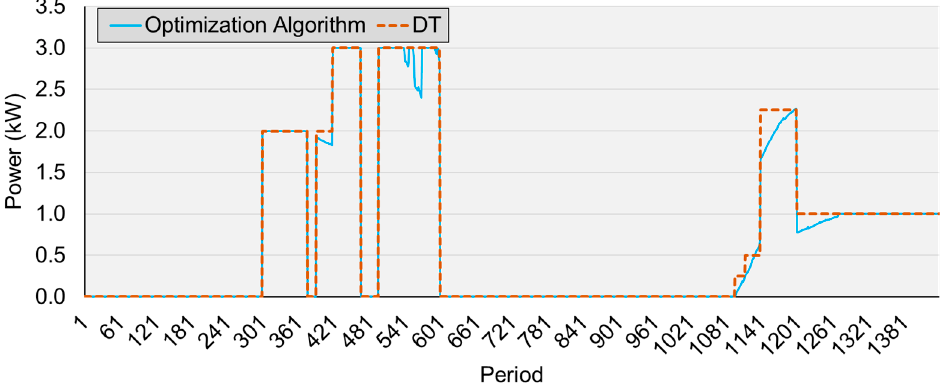
Figure 11. Scheduled generation profile for the synchronous generator during the entire case study.